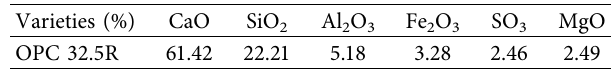
Table 2: Chemical composition of the binder used. Varieties (%)